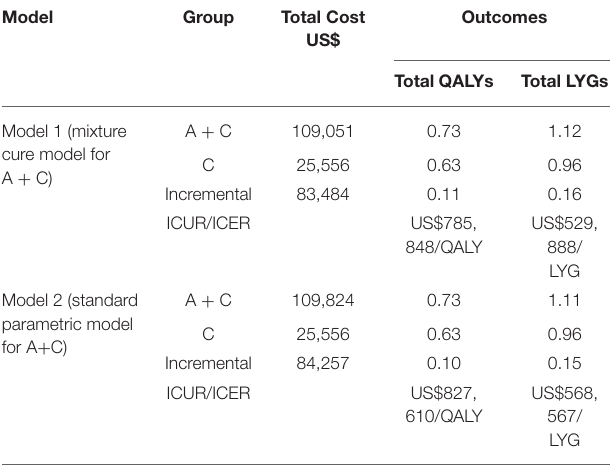
TABLE 2 | Results for the cost-effectiveness analysis in model 1 and model